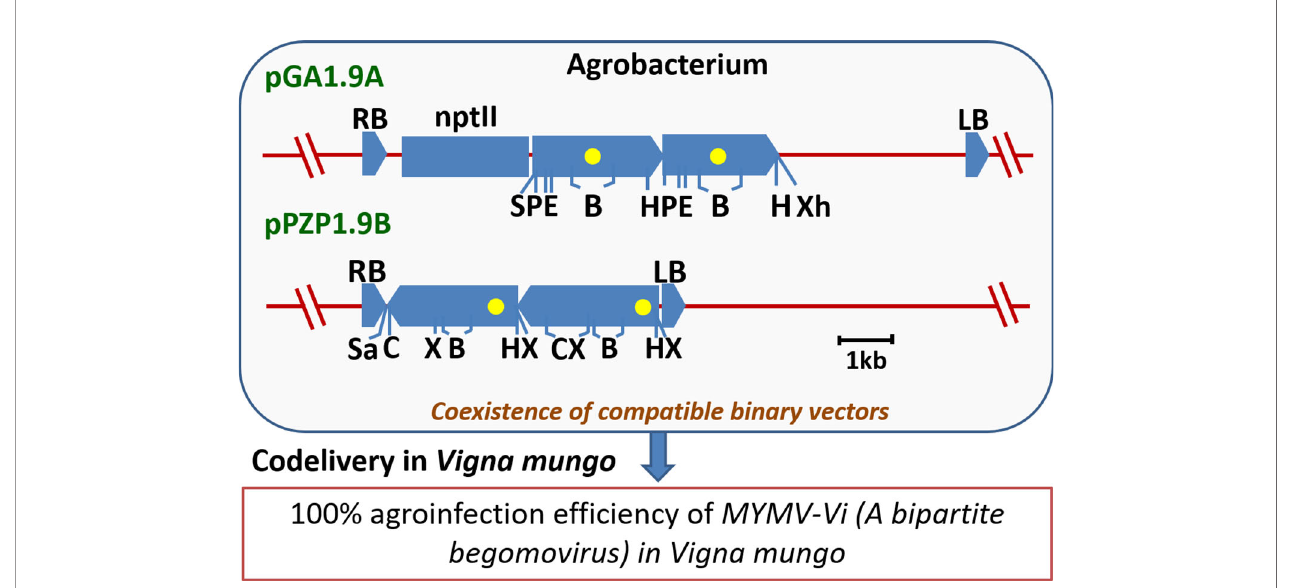
FIGURE 4 | An outline of a simple and ef fi cient, ‘ single-strain agroinfection method ’ of a bipartite begomovirus MYMV-Vi in Vigna . The linear maps of binary vectors represent MYMV-Vi partial tandem repeat regions of DNA-A (pGA1.9A) and DNA-B (pPZP1.9B) having full-length 1-mer portion and the 0.3-mer or 0.9-mer repeat portions of the virus as boxed arrows; Yellow dots: common region; RB and LB: right and left T-DNA borders, respectively; nptII: neomycin phospho-transferase II ; B, BamHI ; C, ClaI ; E, EcoRI ; H, HindIII ; P, PstI ; S, SacI ; Sa, SalI ; X, XbaI ; and Xh, XhoI (Derived from Jacob et al.,